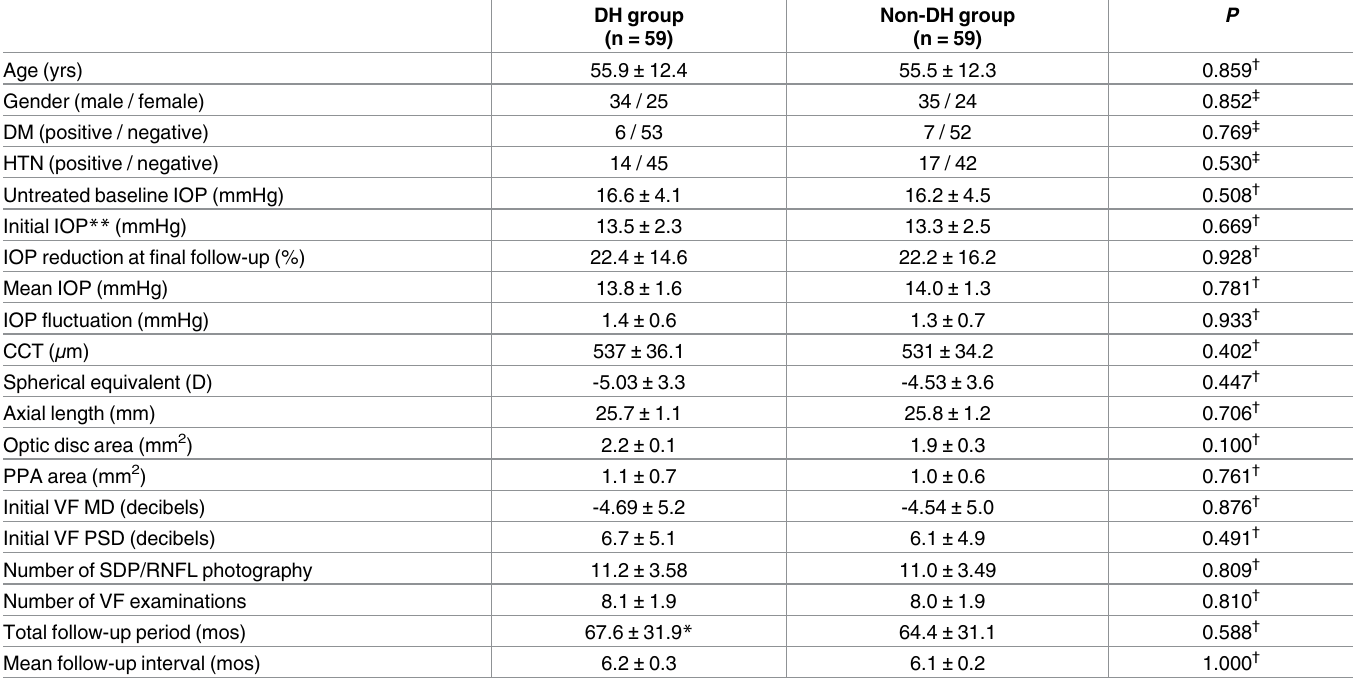
Table 1. Clinical characteristics of myopic primary open angle glaucoma patients with and without optic disc